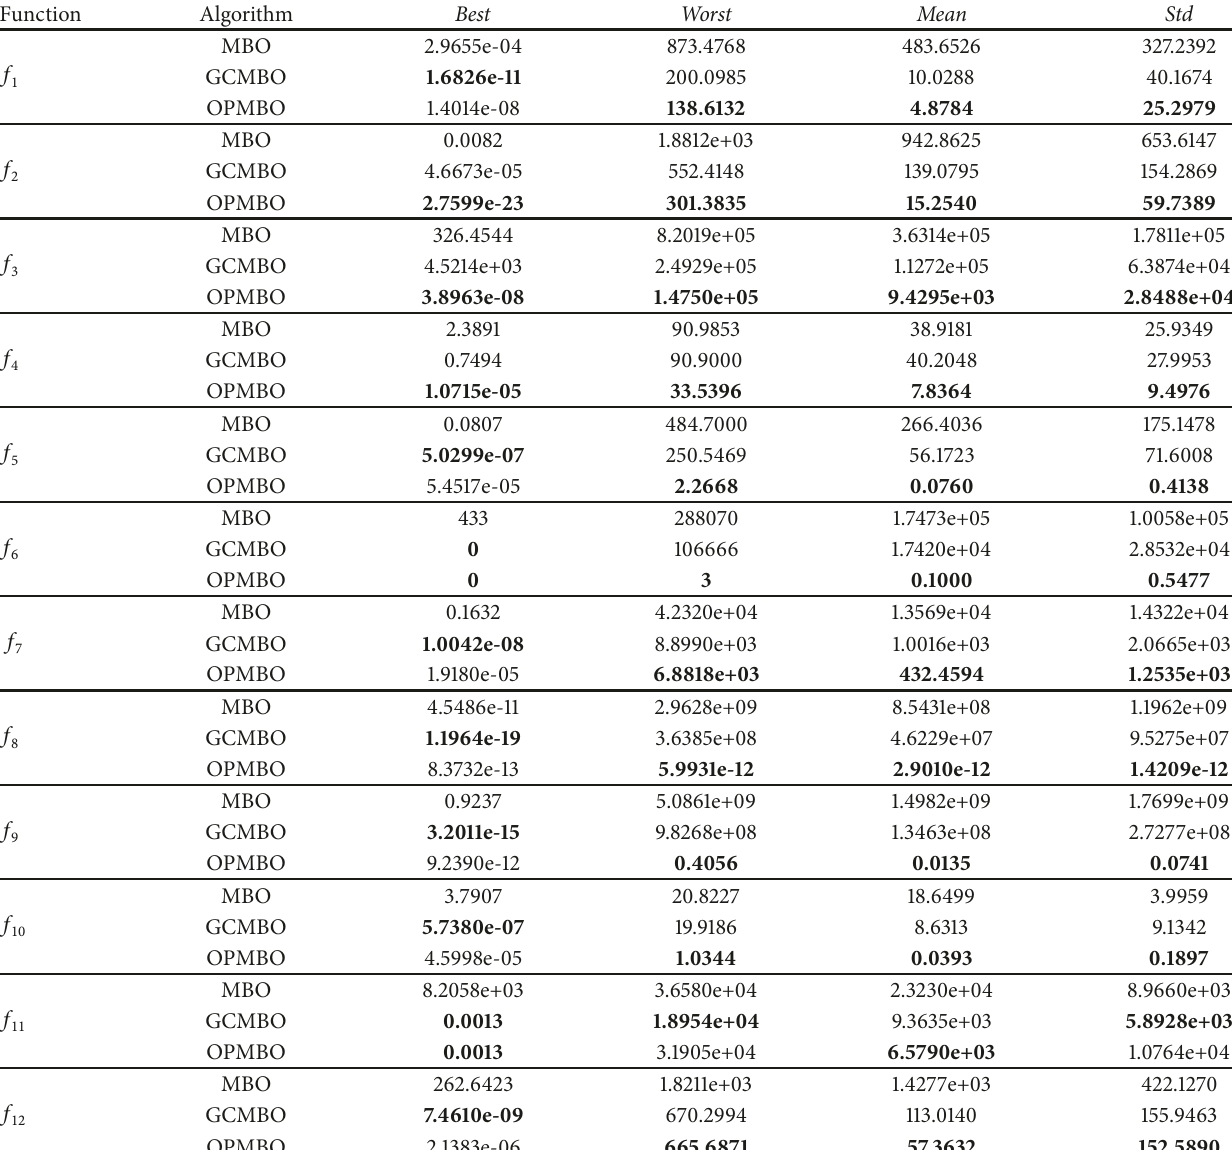
Table 5: The comparison results of the three algorithms on the 100-dimensional benchmark functions.